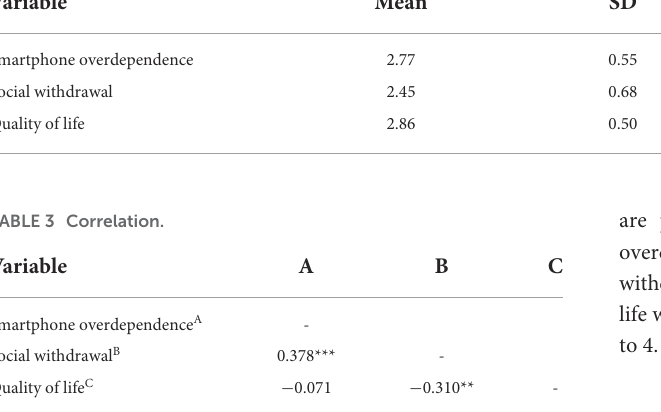
TABLE 2 Descriptive statistics of the main variables. Variable